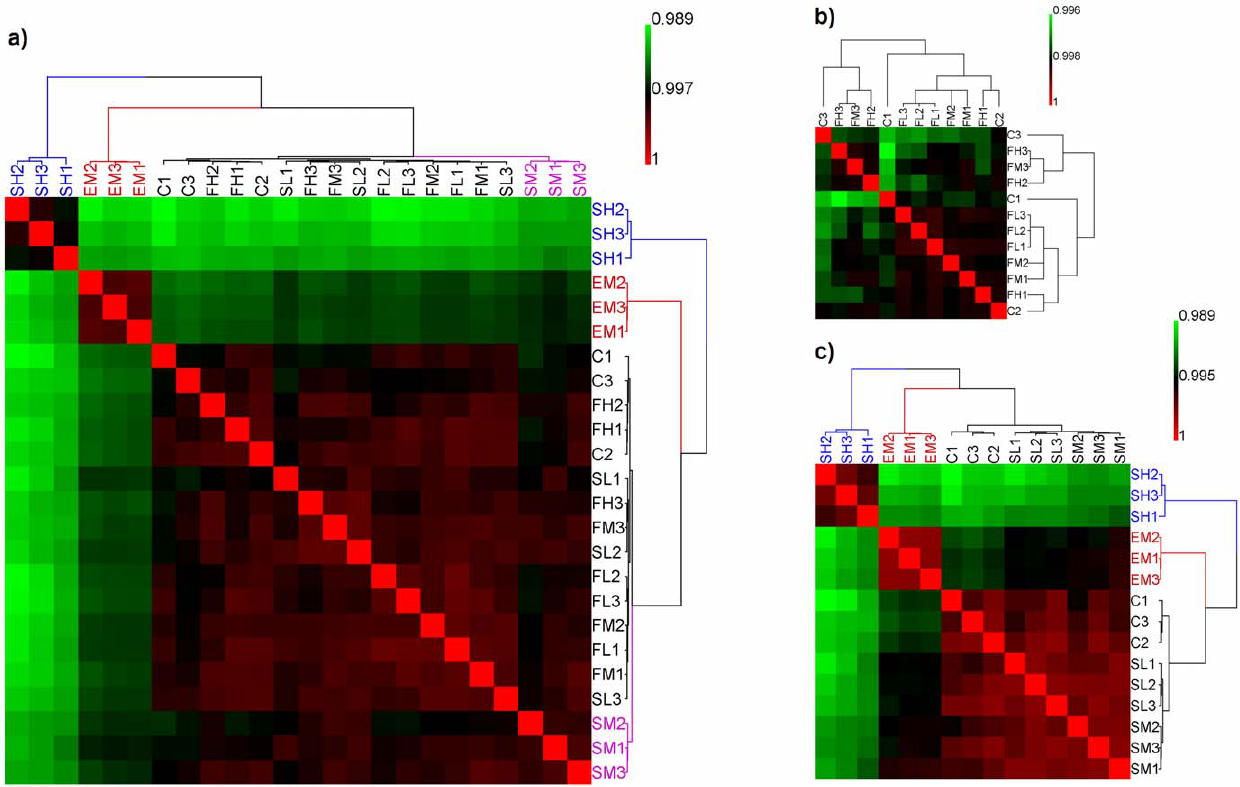
Figure 2. The hierarchical clustering analysis and heatmap of the correlation coefficients between gene expression profiles. (A) All 24 samples from the 8 treatment groups; (B) controls and ferulic acid treatments; and (C) controls and treatments by estradiol and SWT. There was good reproducibility between the three biological replicates in each treatment group. No clear treatment effect was observed for ferulic acid treatments. Low- and medium-concentration SWT treatments showed mild effects, while the strongest treatment effects were seen from estradiol and high-concentration SWT treatments.